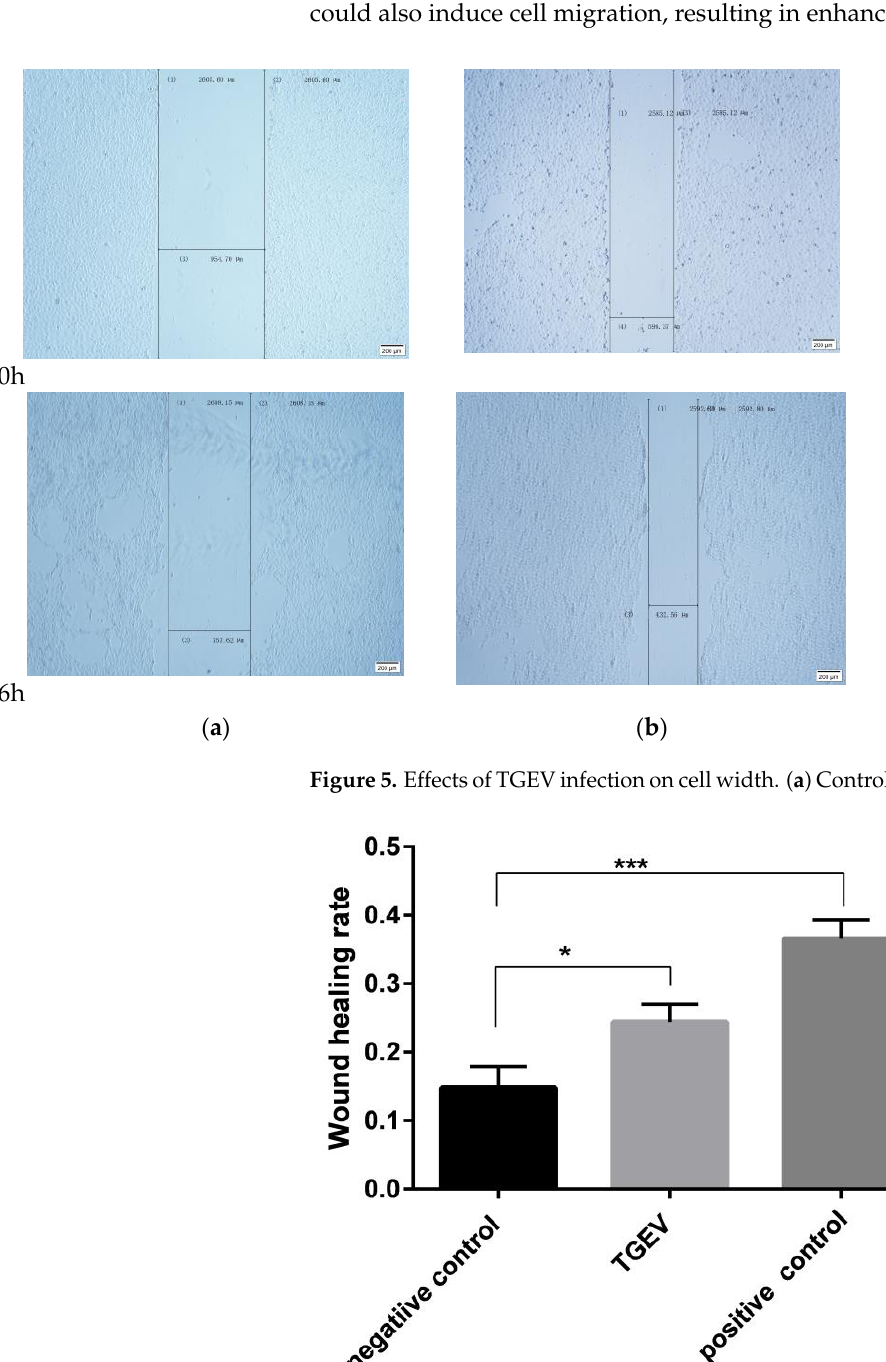
Figure 6. The change of cell scratch healing rate by TGEV infection. * p < 0.05, *** p < 0.001.